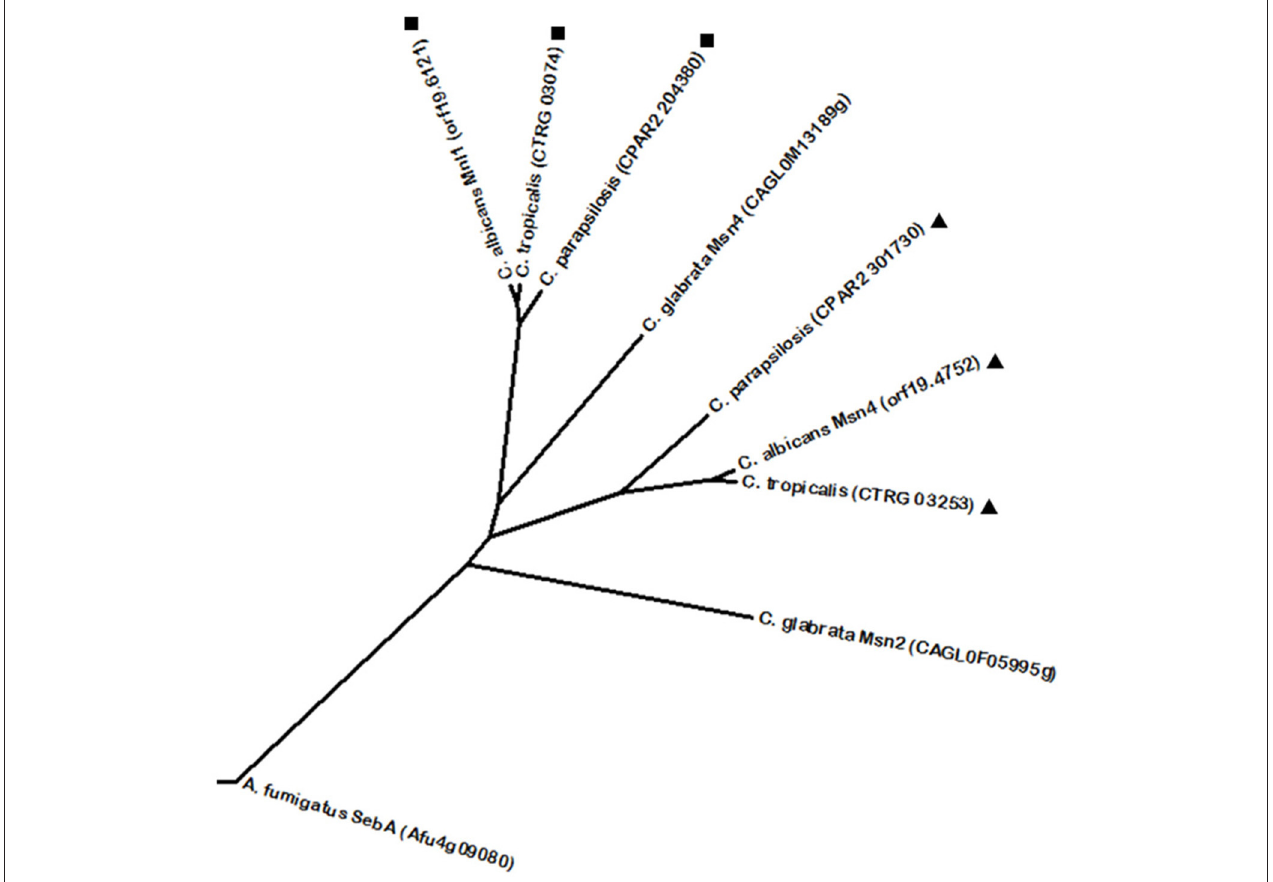
FIGURE 4 | Phylogenetic analysis of the C. albicans Mnl1 and Msn4 homologs. Phylome predicted homologs of Mnl1 are marked with ( (cid:4) ). Phylome predicted homologs of Msn4 are marked with ( N ). Unmarked branches represent additional proteins showing some degree of similarity identified by BLASTp ( E < 10 − 50 ). The tree was constructed using the Molecular Evolutionary Genetics Analysis (MEGA 7) software ( Kumar et al., 2016). Multiple alignments of the amino acid sequences were calculated by ClustalW algorithm ( Sneath and Sokal, 1973). The tree is drawn to scale, with branch lengths in the same units as those of the evolutionary distances used to infer the phylogenetic tree. The evolutionary distances were computed using the JTT matrix-based method ( Jones et al., 1992) and are in the units of the number of amino acid substitutions per site. The rate variation among sites was modeled with a gamma distribution (shape parameter =